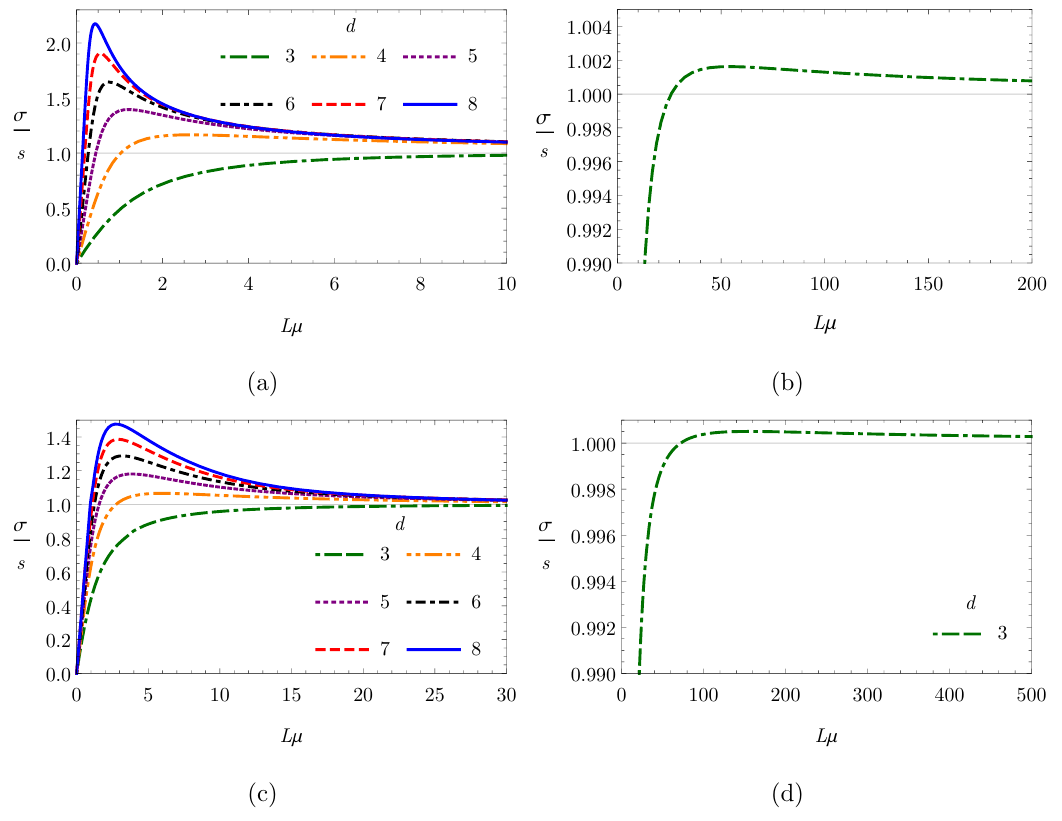
Figure 12. (a) The ED, (cid:27) , in units of entropy density s , versus L(cid:22) for the strip in AdS-RN with d = 3 ; 4 ; 5 ; 6 ; 7 ; 8 and T=(cid:22) = 0. In all cases (cid:27)=s has a single global maximum and (cid:27)=s ! 1 + as L(cid:22) ! 1 . (b) Close-up of (a) for d = 3, showing the maximum. (c) The same as (a), but for the sphere. (d) Close-up of (c) for d = 3, showing the